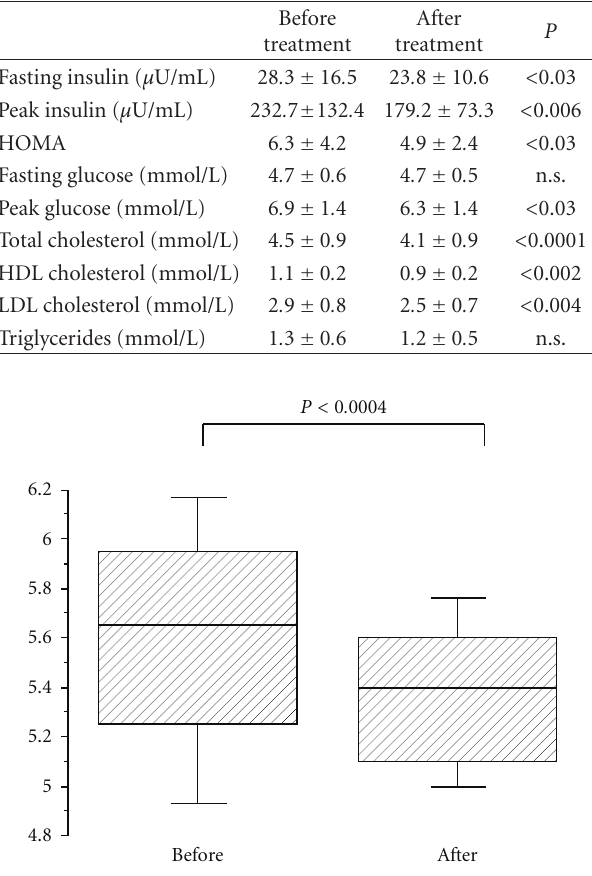
Figure 1: Hemoglobin A 1c before and after weight loss. Hemoglo- bin A 1c (%) was measured before and after weight loss as described in the methods. Box plots represent the 10th, 25th, 50th, 75th, and 90th percentiles. Statistical analysis was performed by Wilcoxon signed rank